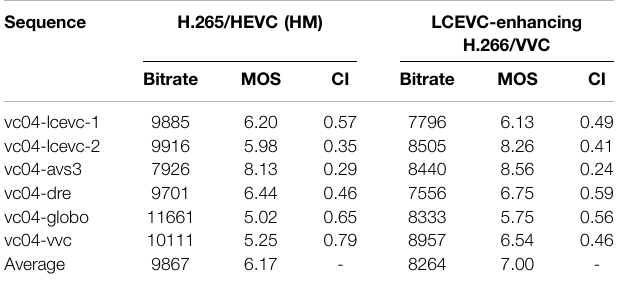
TABLE7| Bitrates,MOSscoresandCIforPQsequences.LCEVCandbaselayer in two separate 6MHz/5Mbps channels. Sequence